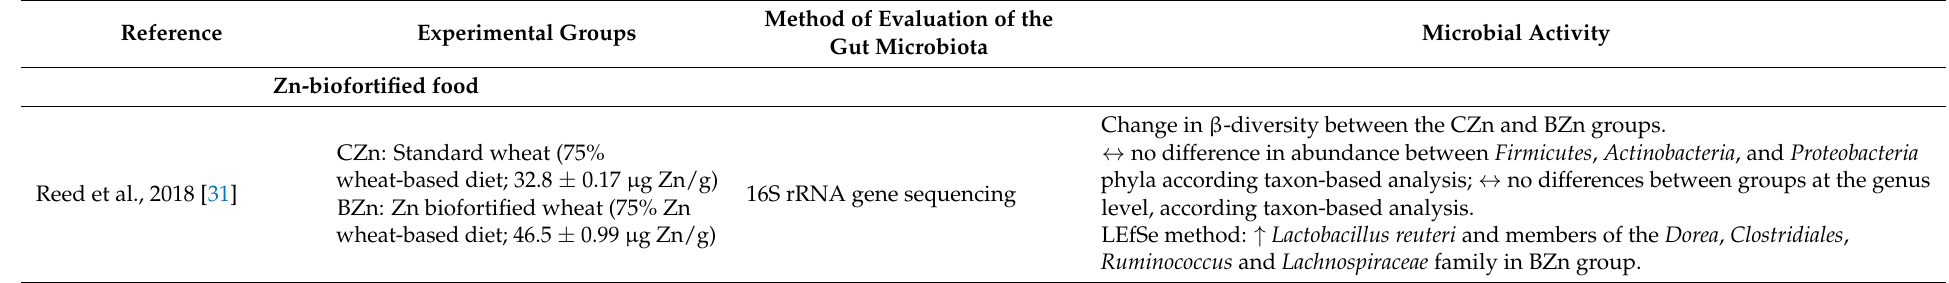
Table 3. Methods and main findings in studies on the use of Fe and Zn biofortified foods in gut microbiota